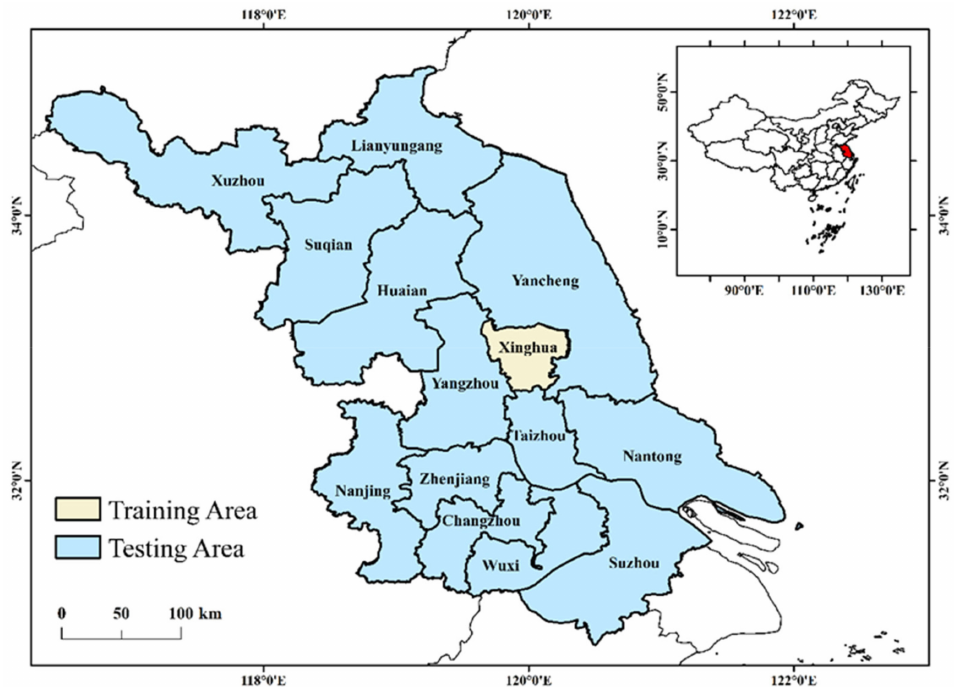
Figure 1. Location of study area, including training area, Xinghua County, and testing area, Jiangsu